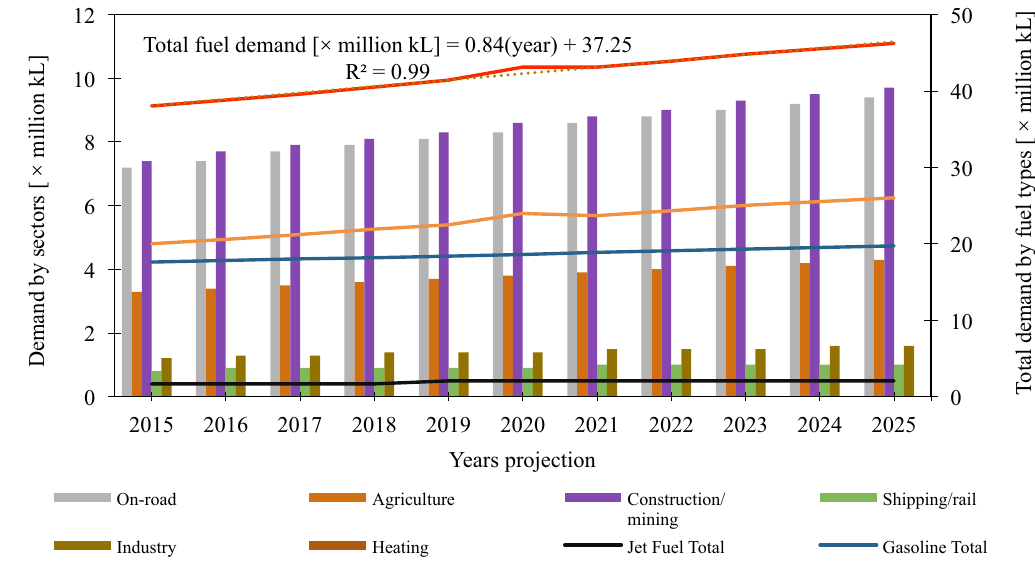
Fig. 2. Australian fuel use projections, 2015 up to